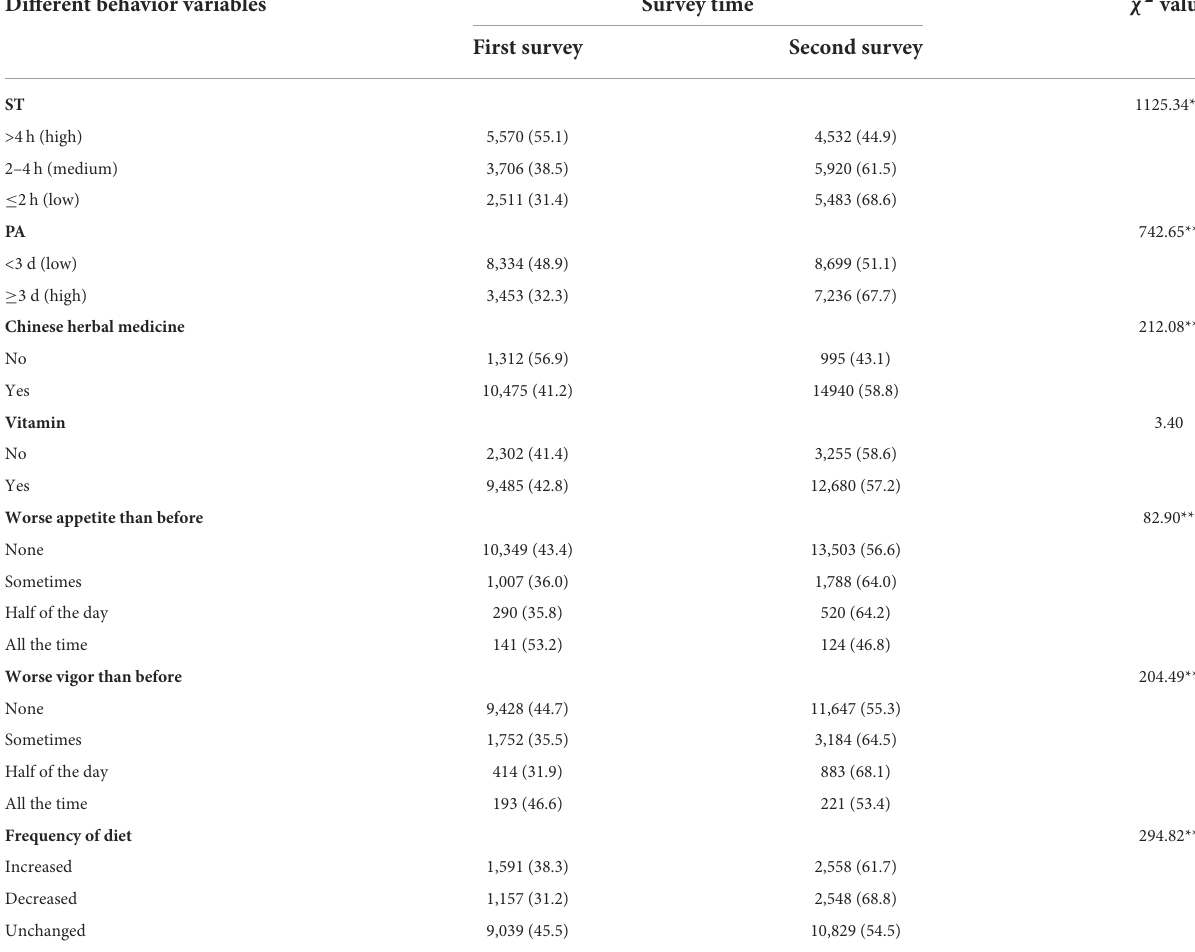
TABLE 4 The association between health behaviors and mental health among college